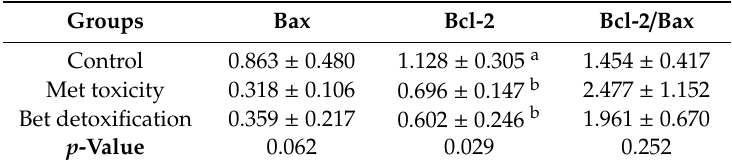
Figure 2. Northern blot analysis of the Bcl-2 associated protein X (Bax) and B-cell lymphoma 2 (Bcl-2) genes in the control group and methionine toxicity group. The numbers 1330X, 1332X, 1372X, 1359X, and 1493X correspond to the control group; the numbers 1493X, 1420X, 1239X, and 1207X correspond to the methionine (Met) toxicity group; and the numbers 1369X, 1441X, 1210X, and 1488X correspond to the betaine (Bet) detoxification group. The control group received the basal diet from 14 to 70 d of age. The Met toxicity group received the basal diet supplemented with 1% Met. The Bet detoxification group received the Met toxicity diet supplemented with 0.2% Bet. Table 4. Effects of betaine on the protein expression of Bax and Bcl-2 in cardiomyocytes of geese with hyperhomocysteinemia.